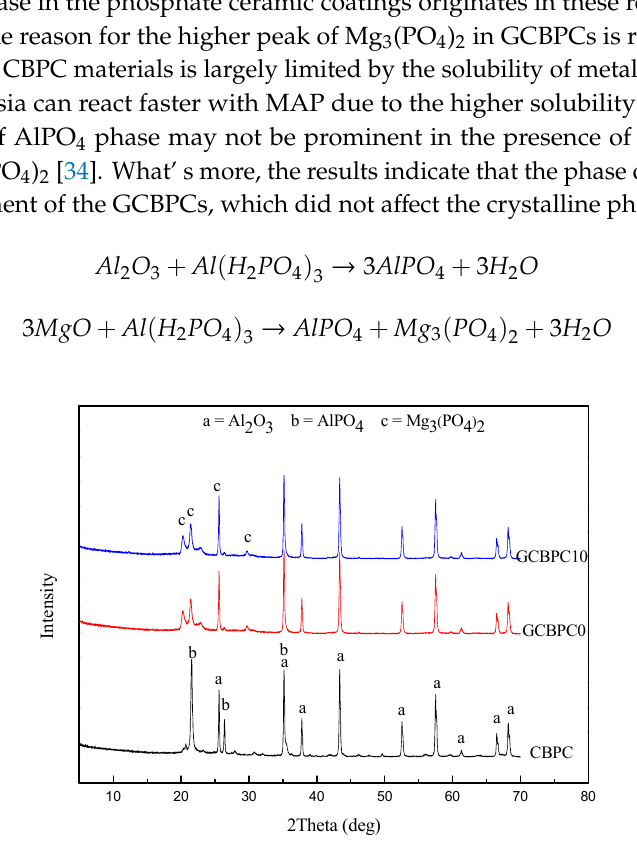
Figure 4. XRD patterns of phosphate ceramic coatings.